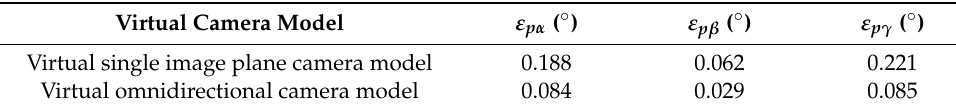
Table 2. Angle errors in different virtual camera